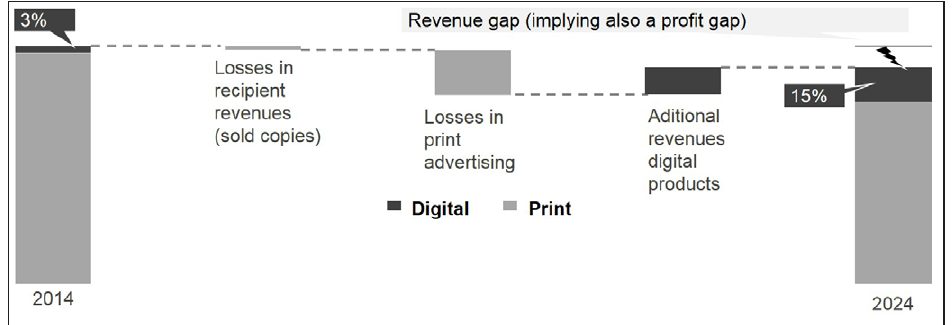
Figure 11: Exemplary revenues for a regional newspaper publisher (optimistic scenario). Source : Own elaboration based on model